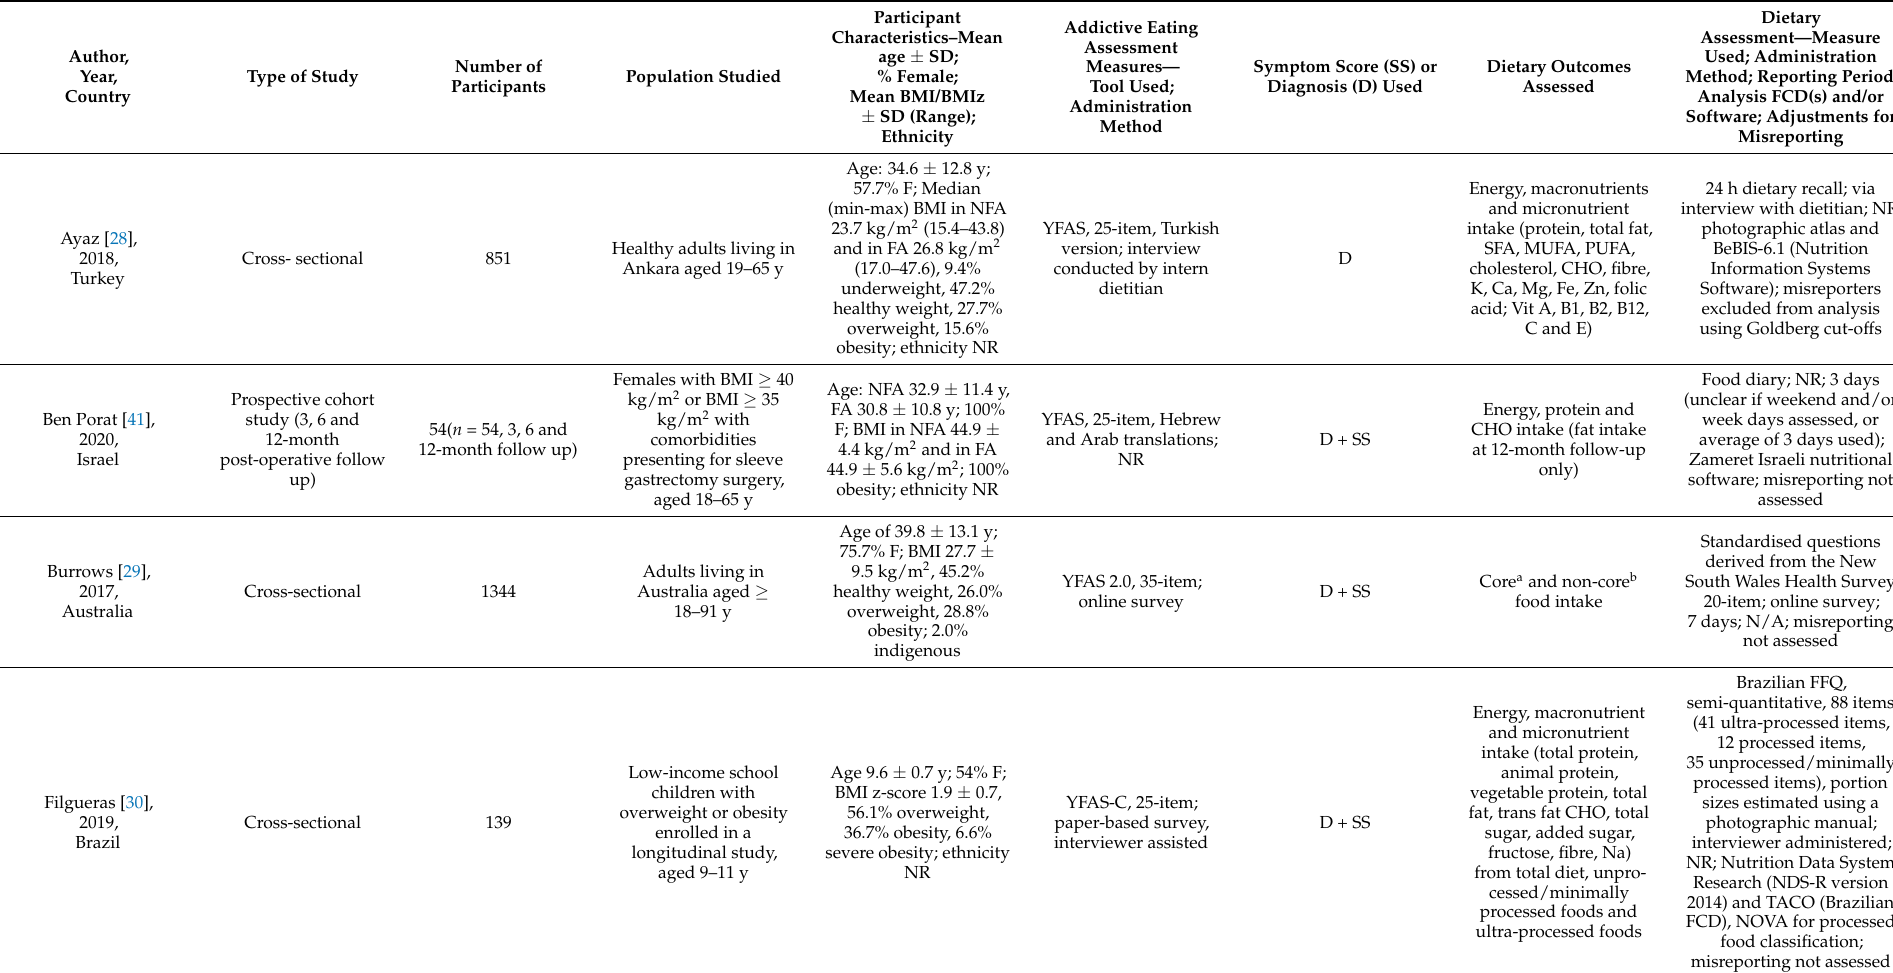
Table 2. Description of included